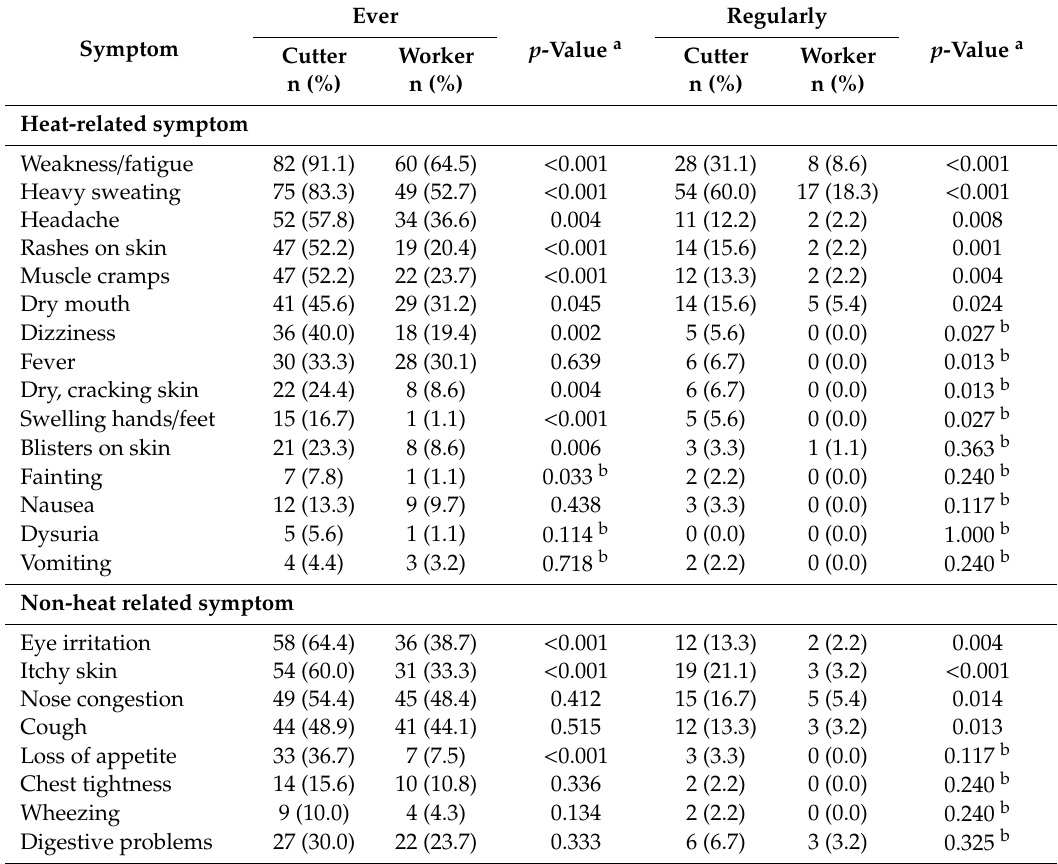
Table 6. Prevalence of symptoms reported by sugarcane worker during the harvesting